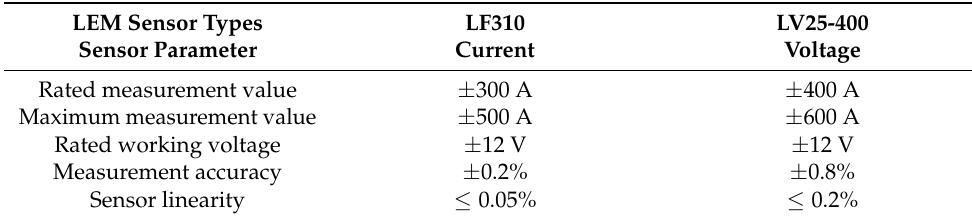
Table 2. Technical parameters of the sensors.